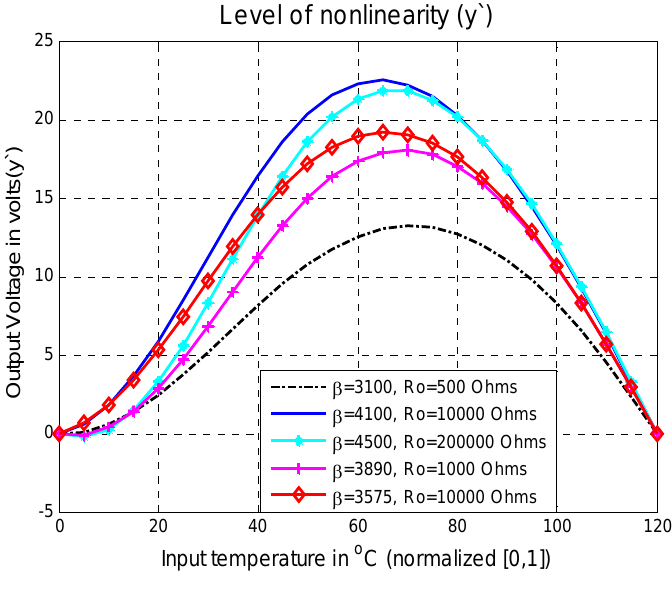
Figure 10. Feature of nonlinearity of the thermistors used in the temperature measurement system (Ro is the resistance of the thermistor at 25 o